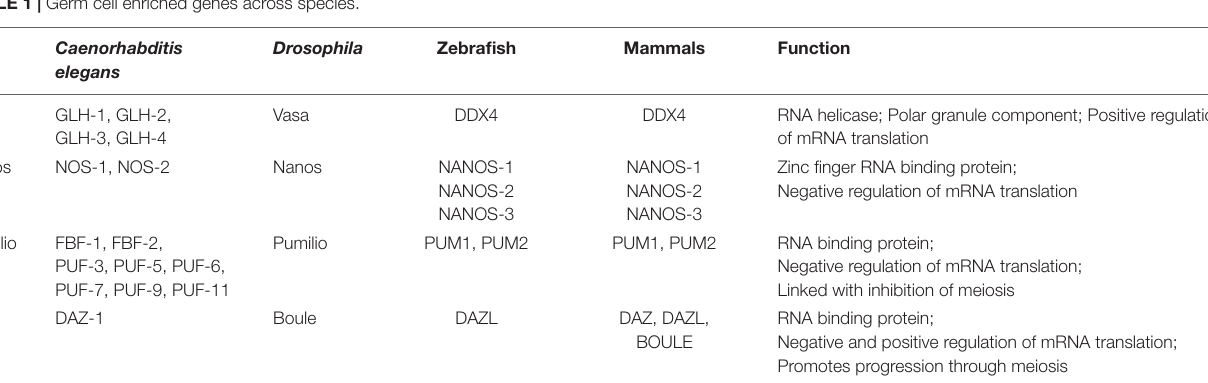
FIGURE 1 | Schematics of where Drosophila , Caenorhabditis elegans , and mouse PGCs originate from and adult ovary structures. TABLE 1 | Germ cell enriched genes across